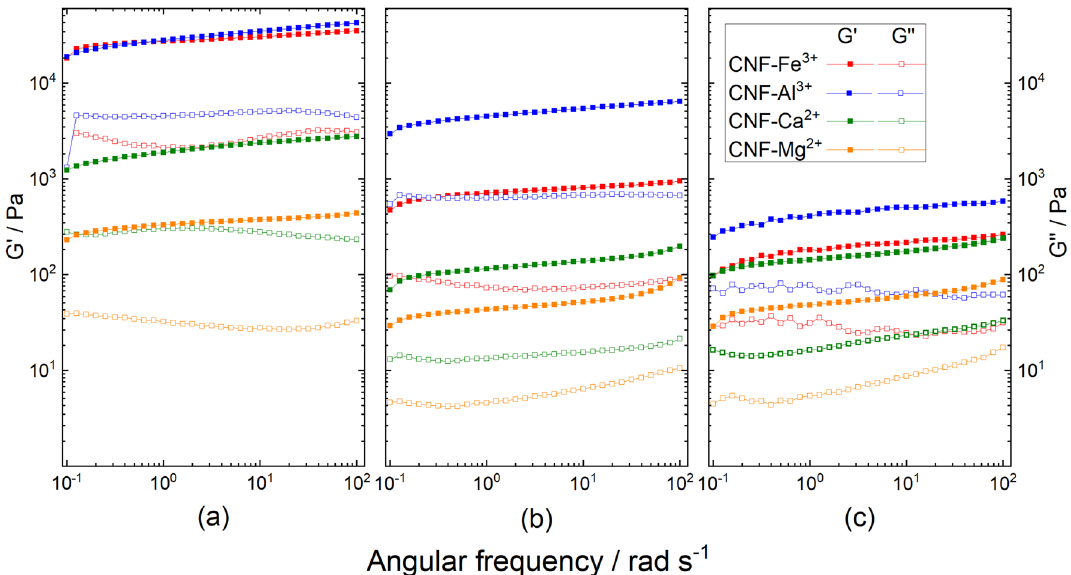
Figure 4. Viscoelastic properties of the TOCNF–M n+ hydrogels with various cations:Fe 3+ , Al 3+ , Ca 2+ , and Mg 2+ are presented in red, blue, green, and orange, respectively. M n+ :TOCNF(:H 2 O) ratios: ( a ) 1:1, ( b ) 1:1:25, and ( c )